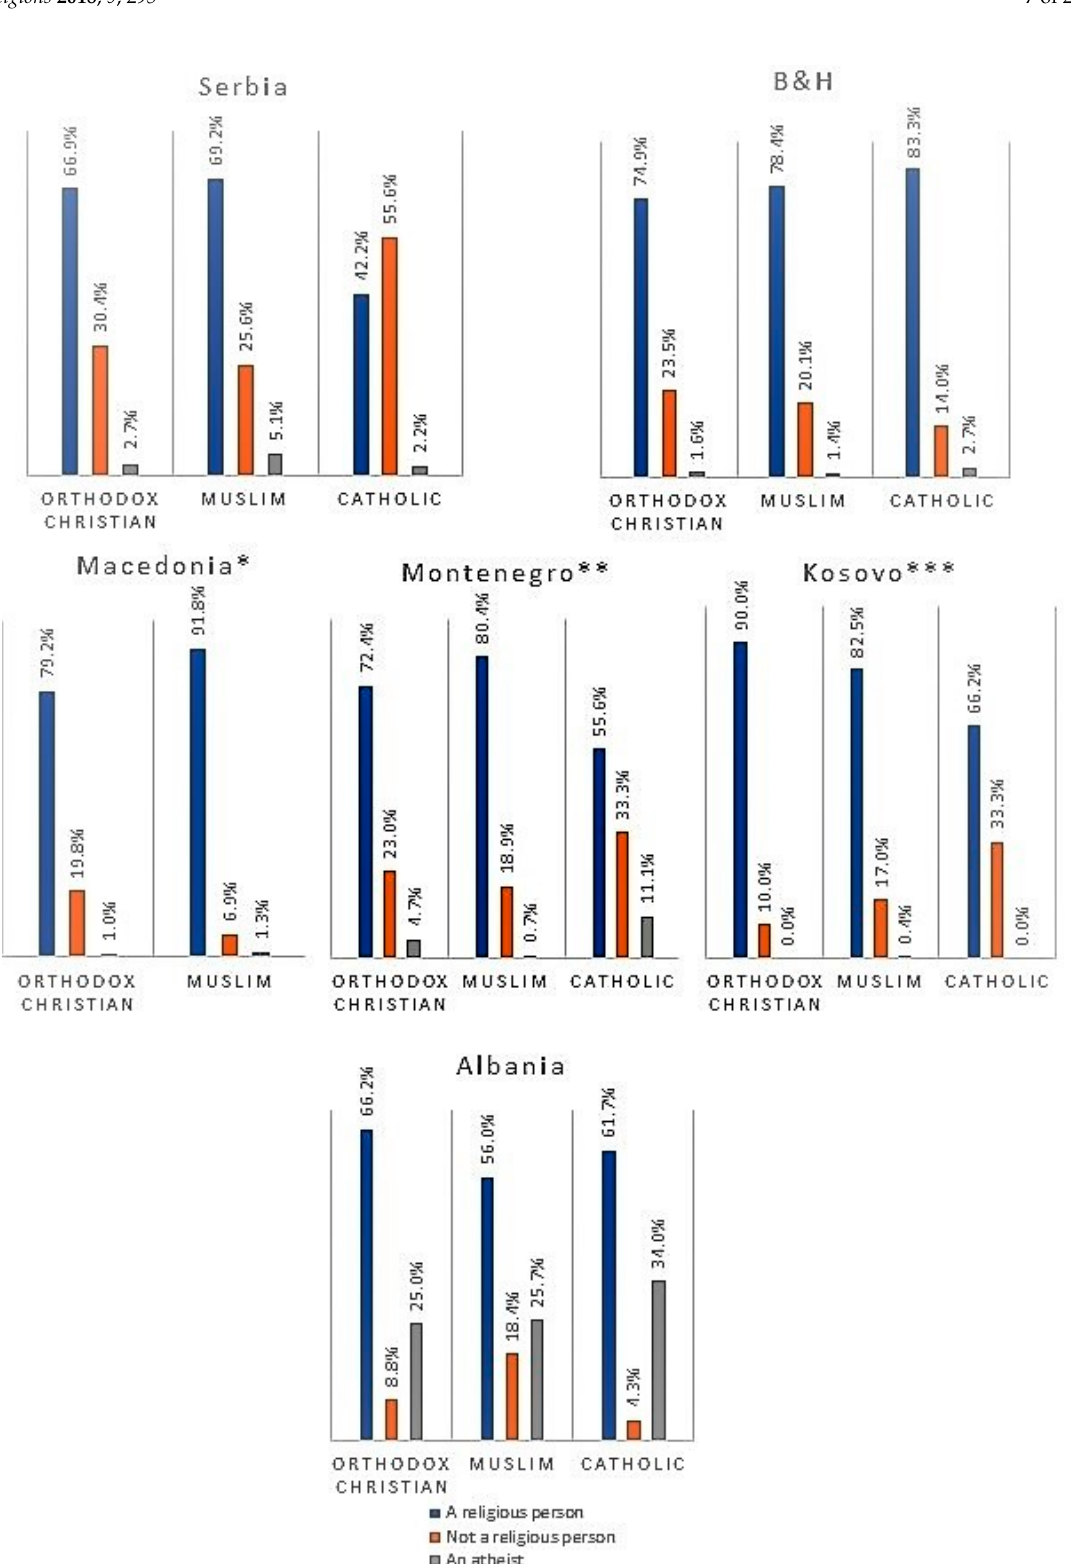
Figure 4. Religious self-declaration by confession and country. Note: * Taking into account that the number of Catholics in Macedonia was extremely small, this category was excluded from the analysis. ** Taking into account that the number of members of other confessions in Montenegro was extremely small, these categories were excluded from the analysis. *** Taking into account that the number of members of other confessions in Kosovo was extremely small, these categories were excluded from the analysis.